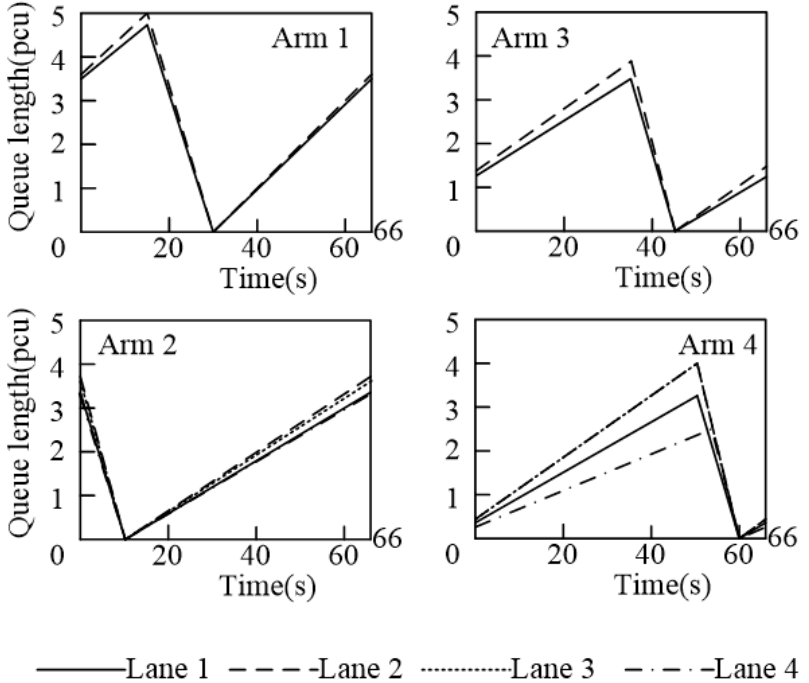
Figure 7. Queue length (in pcu) against time (from start to end of a signal cycle in seconds) from the optimized traffic signal settings in morning-peak period.